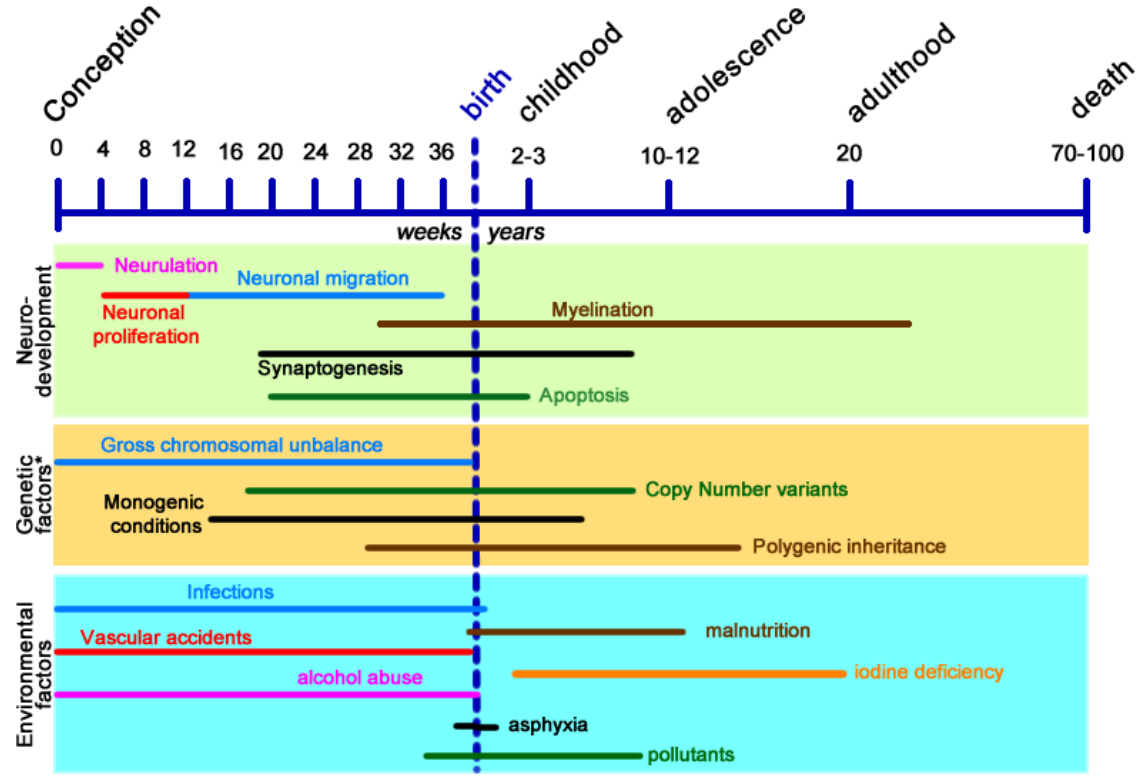
Figure 2. Schematic representation of neurodevelopmental stages, related to genetic and environmental factors and their time window. *For genetic factors, the onset of symptoms or time of detection is shown. Modified from